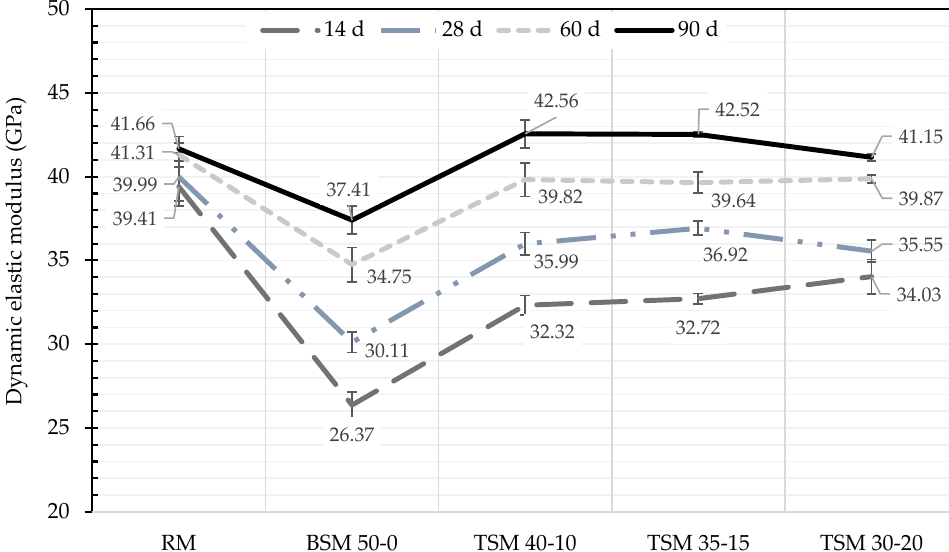
Figure 7. Dynamic elastic moduli of RM, BSM 50-0, TSM 40-10, TSM 35-15, and TSM 30-20 mortars at 14, 28, 60, and 90 days.